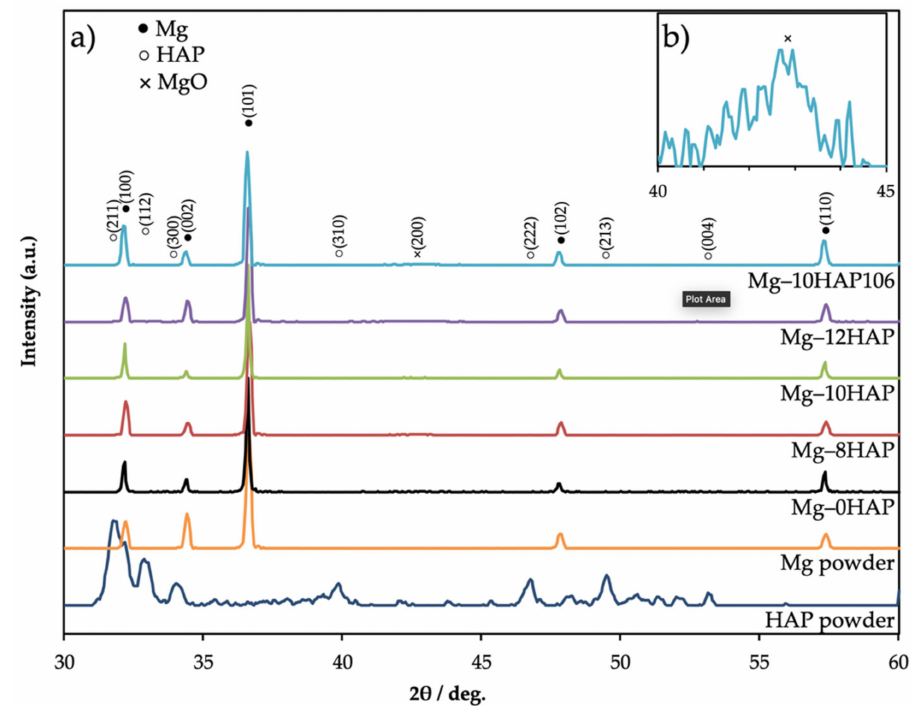
Figure 7. ( a ) XRD results of the raw magnesium and hydroxyapatite powders and the sintered magnesium–hydroxyapatite composites after sintering. Inset ( b ) is the magnified XRD pattern which shows the MgO peak of Mg–10HAP106 as an